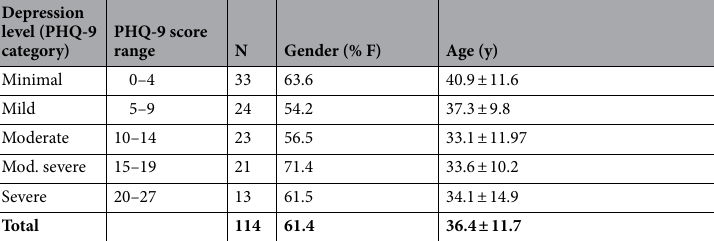
Table 1. Demographic information of study sample.